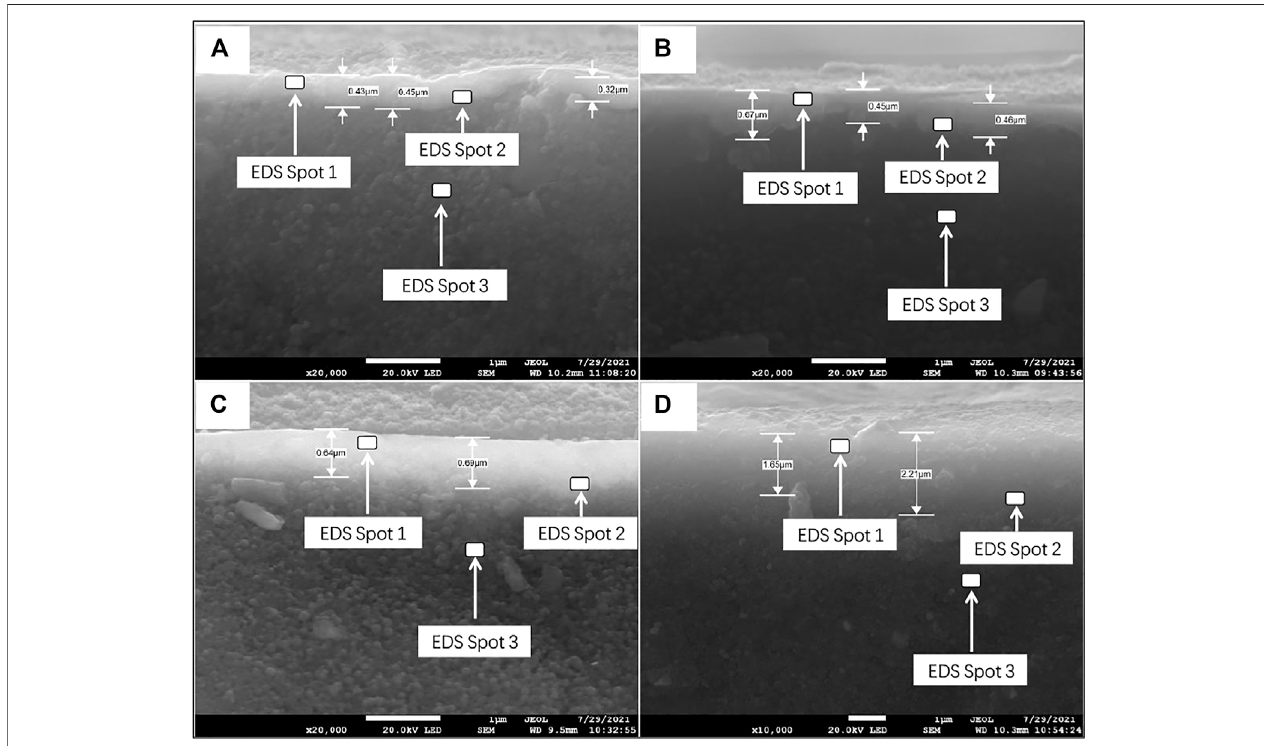
FIGURE 4 | The thicknesses of oxidation fi lms on different samples measured by backscattered electrons: (A) pure Mg; (B) Mg-3Y; (C) Mg-5Y; (D) Mg-7Y.